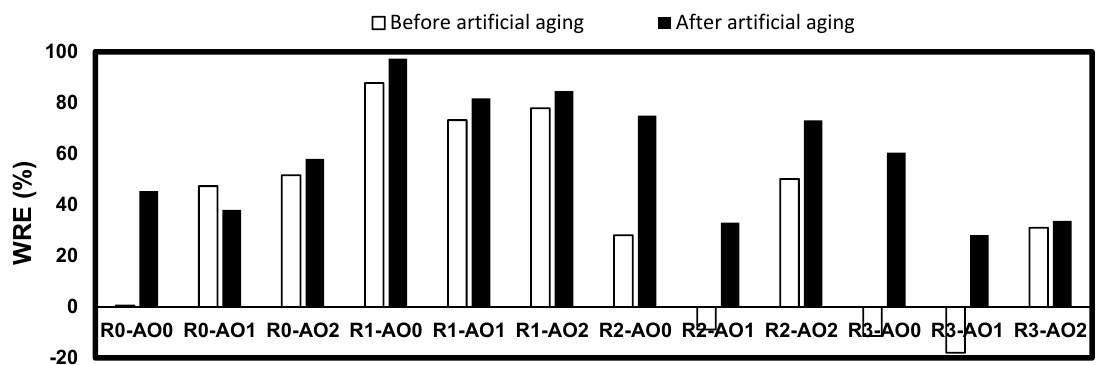
Figure 3. Water repellent efficiency (WRE) of the white pine before and after artificial aging